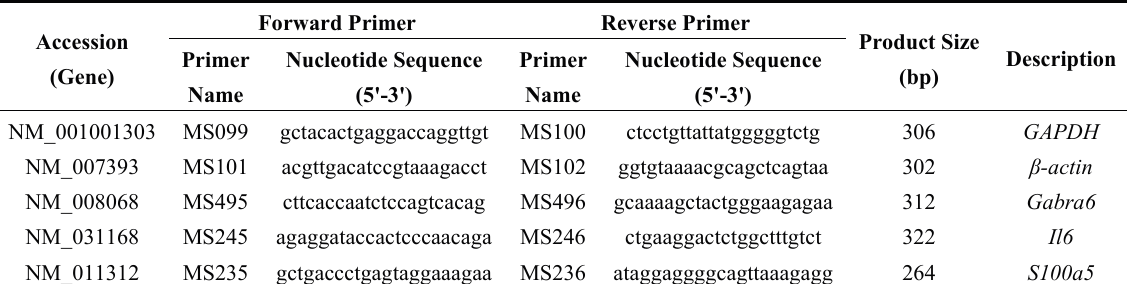
Table 1. Primer combinations used for